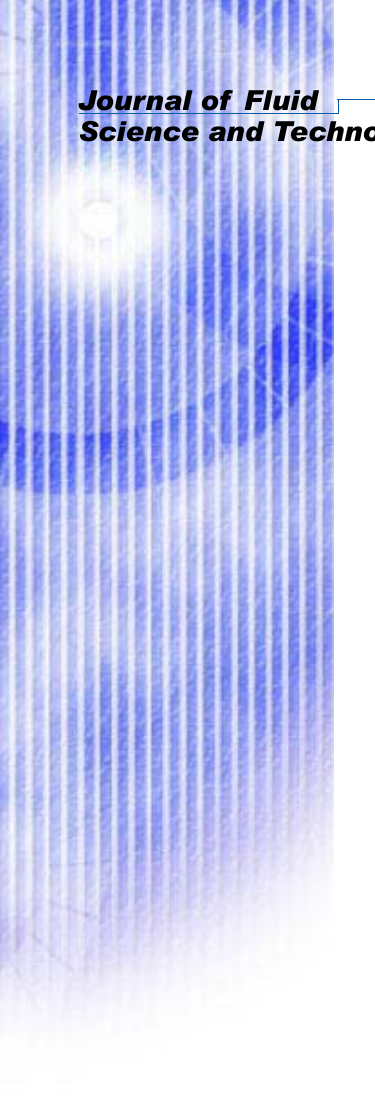
Fig. 13 Dependence of (a) real and (b) non-dimensional amplitudes of wave on the excitation